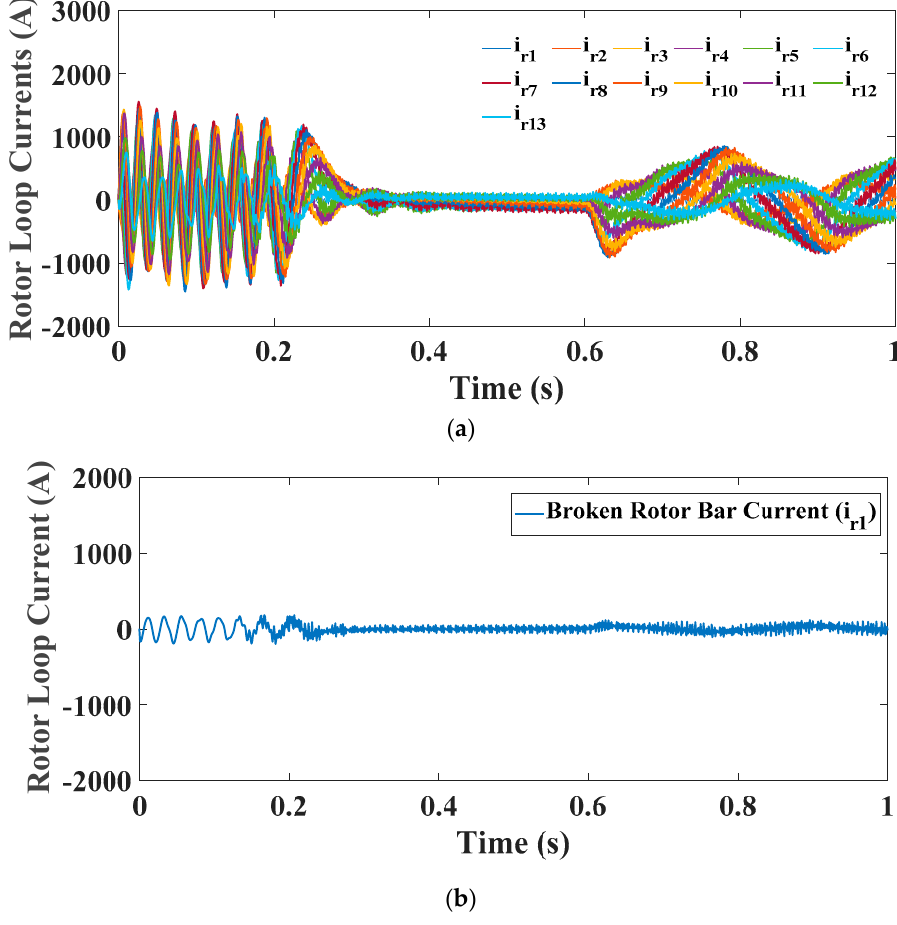
Figure 13. ( a ) BRB-rotor loop currents; ( b ) Broken rotor bar current.